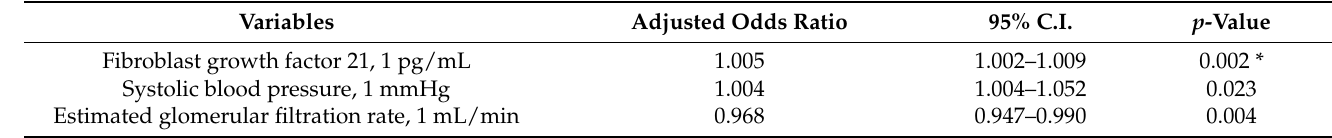
Table 2. Possible predictors of aortic stiffness of T2DM